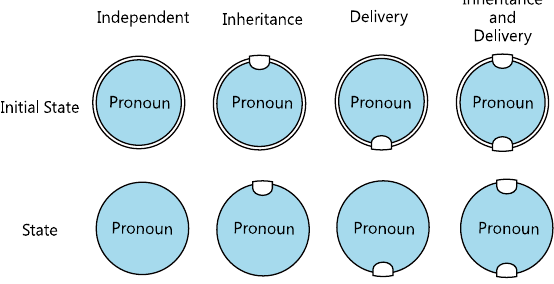
Figure 5. The event present in symbol with year and action information